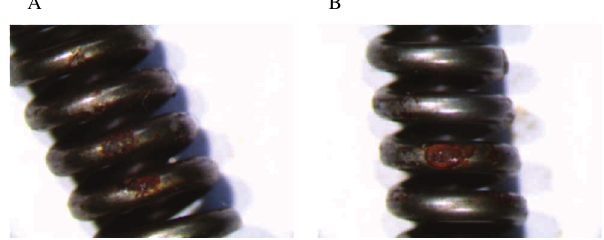
Fig. 9. A – injector needle spring, B – spring in electromagnetic solenoid